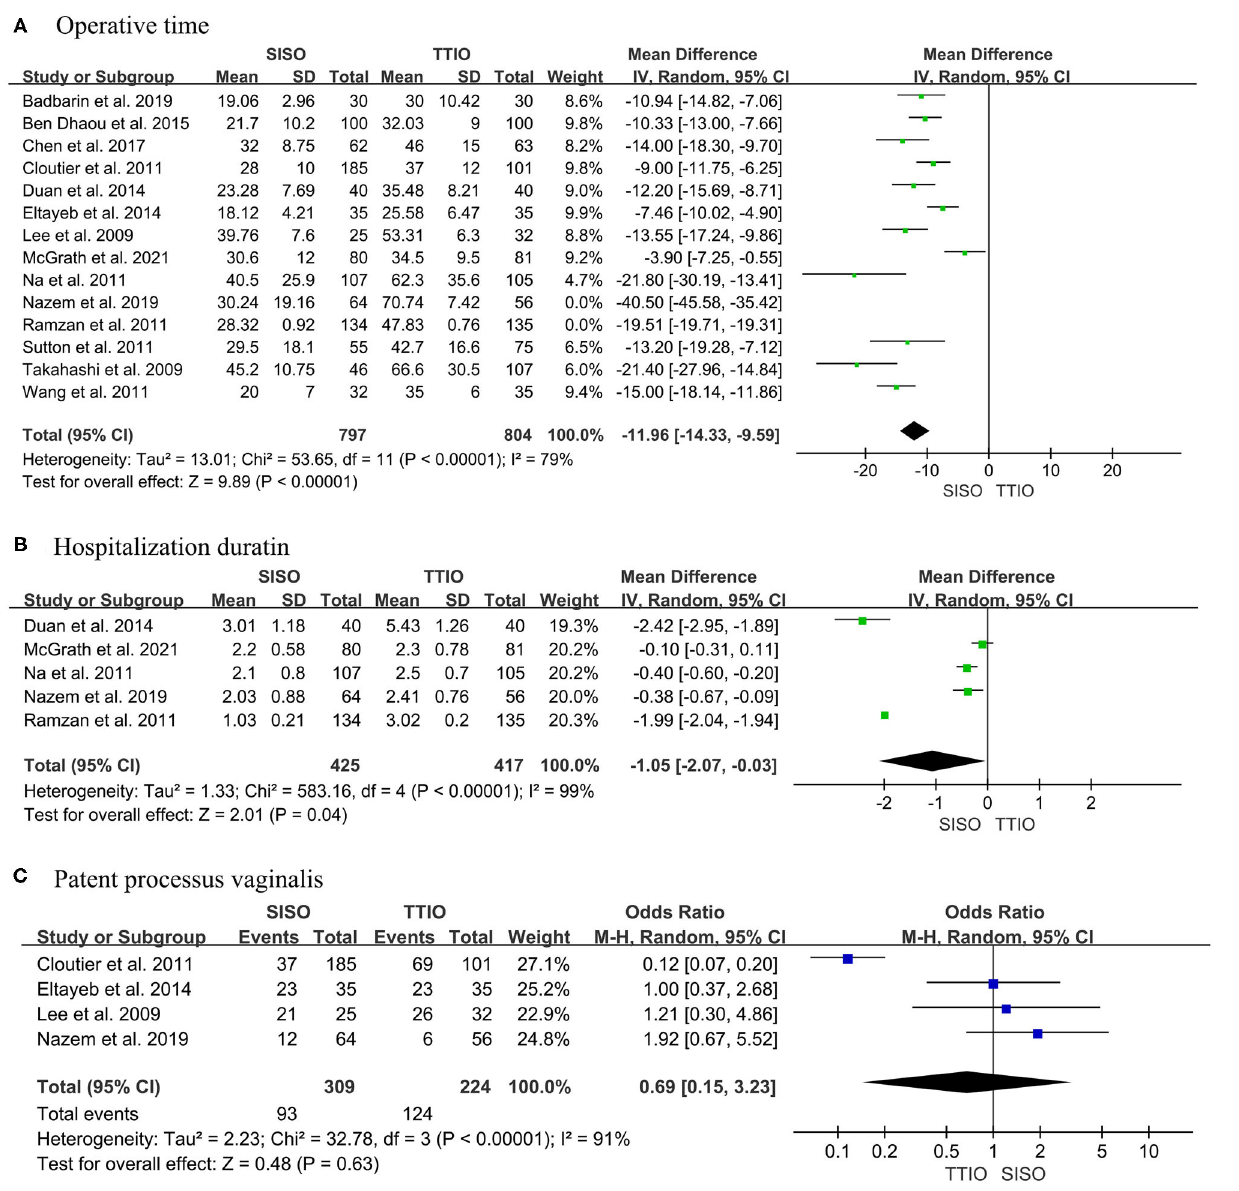
FIGURE 2 | Forest plot of (A) operative time, (B) hospitalization duration, and (C) patent processus vaginalis between single-incision scrotal orchiopexy and traditional two-incision inguinal orchiopexy for primary palpable undescended testes.